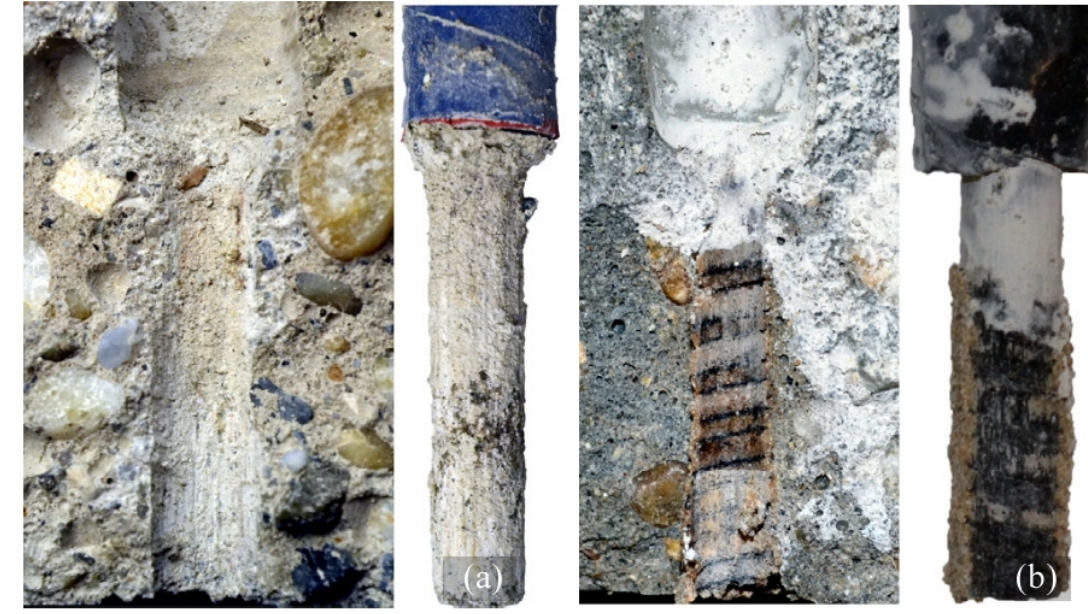
Figure 9. Failure types: ( a ) Concrete shear failure; ( b ) Peeling of rebar [36]. Table 6. Studies on the influence of concrete compressive strength on FRP–concrete bond strength.